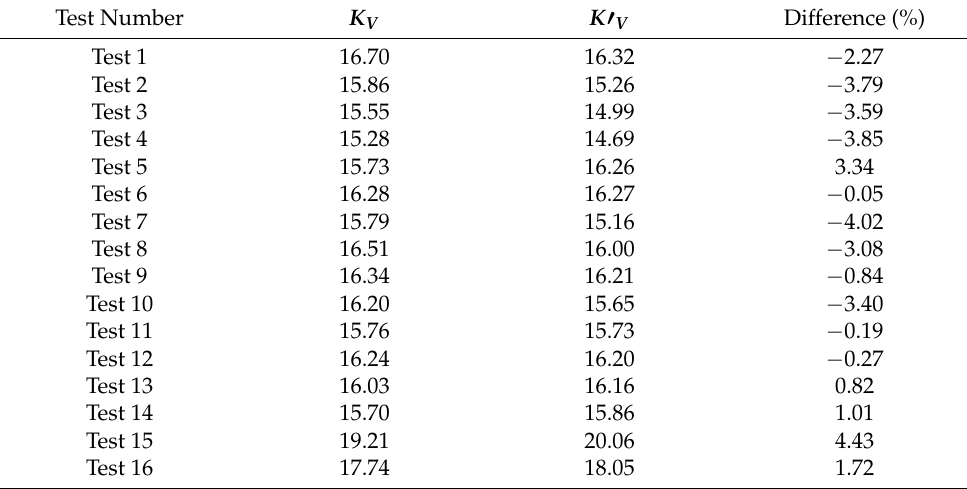
Table 5. Comparison between the vertical stiffness coefficients from expressions and finite ele- ment